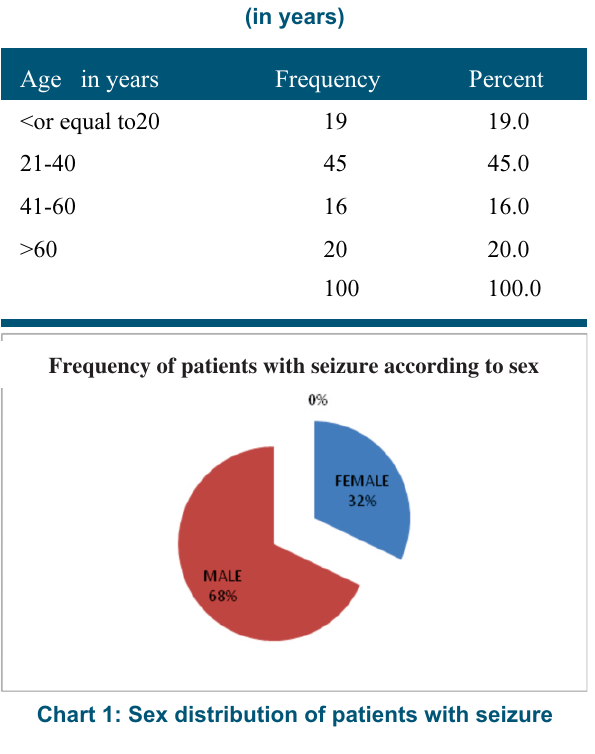
Table 2: Demographic characters of patients with